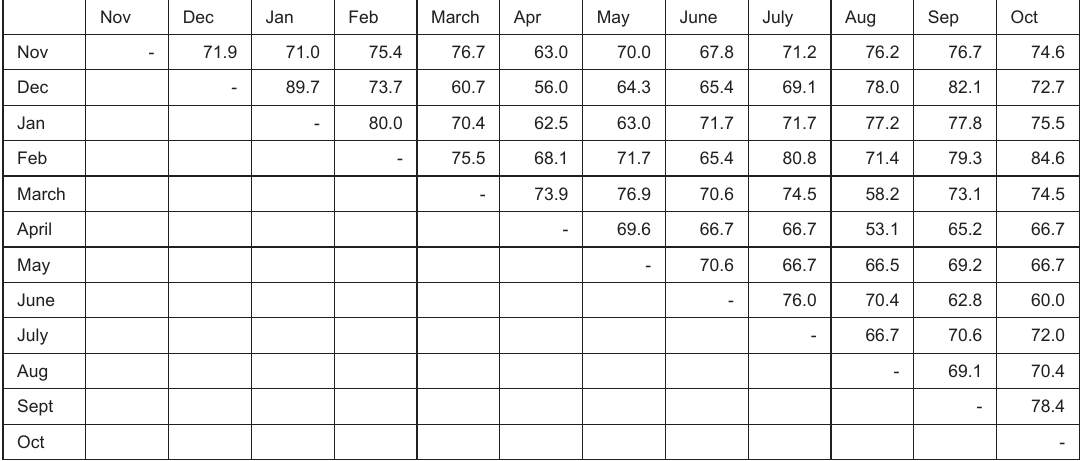
and dissolved oxygen (r the sampling stations. Besides, it registers positively correlation with alkalinity (r and phosphate (r